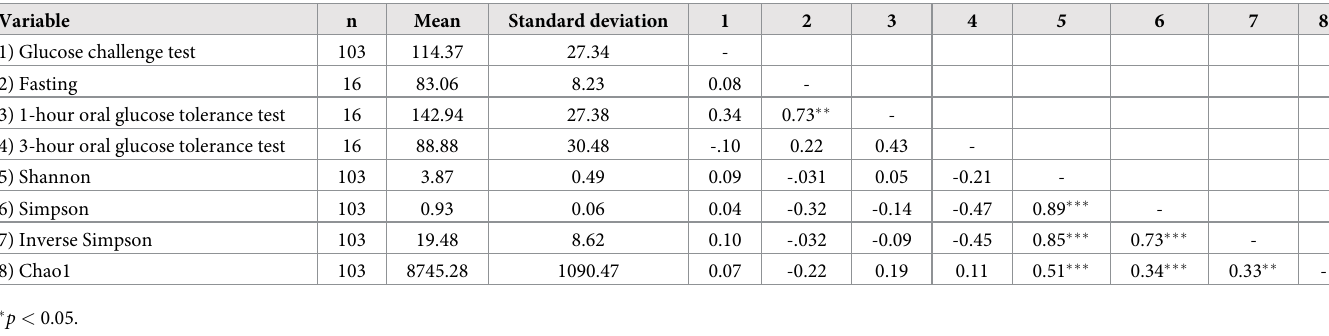
Table 3. Correlation between microbiome diversity metrics and maternal blood glucose values in the entire sample.